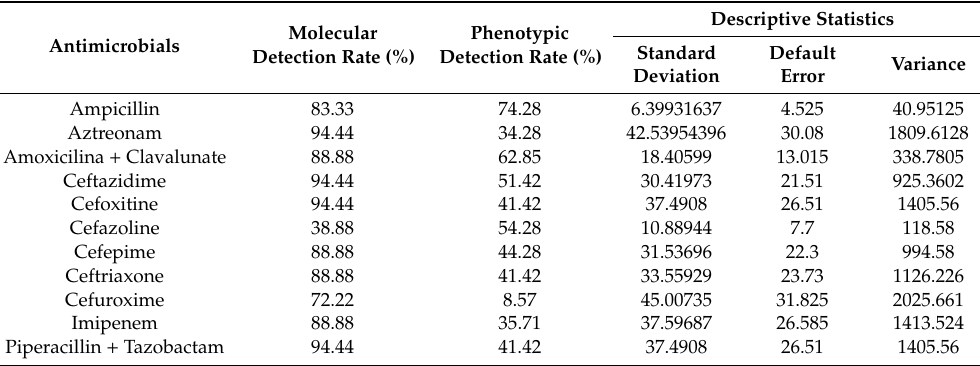
Table 2. Rates of detection of phenotypic and molecular antimicrobial resistance.